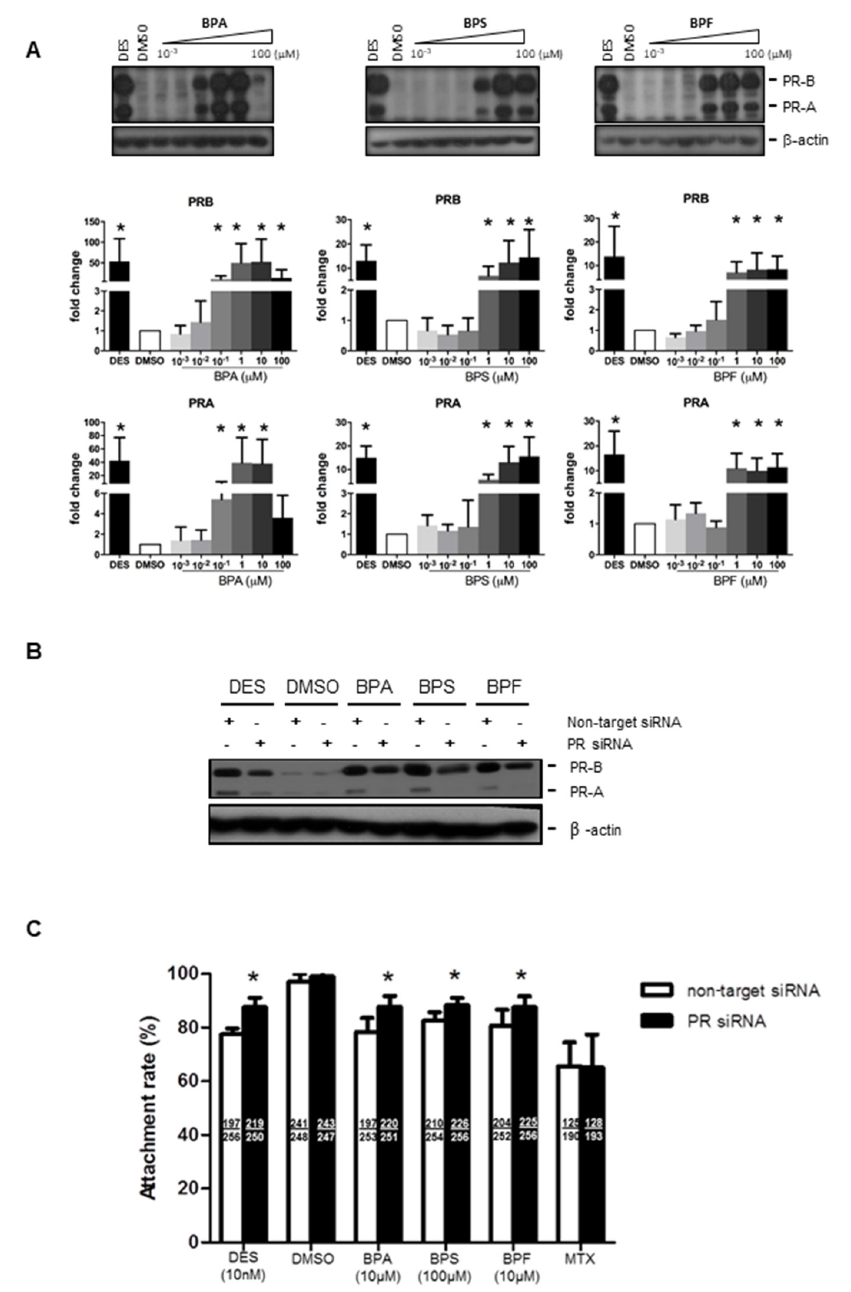
Figure 3. Effect of BPA, BPF, and BPS on the expression of PR-A and PR-B in Ishikawa cells and spheroid attachment. ( A ) BPA, BPF, and BPS (0.001 to 100 μ M) treatment upregulated the expression of progesterone receptors PR-A and PR-B in Ishikawa cells. Western blot analysis demonstrated upregulation of PR-A and PR-B in treated Ishikawa cells (top panel). Semi-quantitative analysis demonstrated more than 10 to 50-fold increase in PR-A and PR-B expression in treated Ishikawa cells ( n = 4). ( B ) PR siRNA downregulated PR-A and PR-B expression with BPA, BPF, and BPS treatment in Ishikawa cells. Western blot analysis demonstrated DES, BPA, BPS, and BPF, but not DMSO, upregulated PR-A and PR-B expression. PR siRNA suppressed the stimulation of PR expression by bisphenols in Ishikawa cells. ( C ) PR siRNA, but not non-target siRNA, reversed the suppressive effects on spheroid attachment by bisphenol-treated Ishikawa cells. DES was used as a control in the attachment assay. The number of attached spheroids over the total spheroids added is shown in each bar. * denotes p < 0.05 compared with non-target siRNA control.